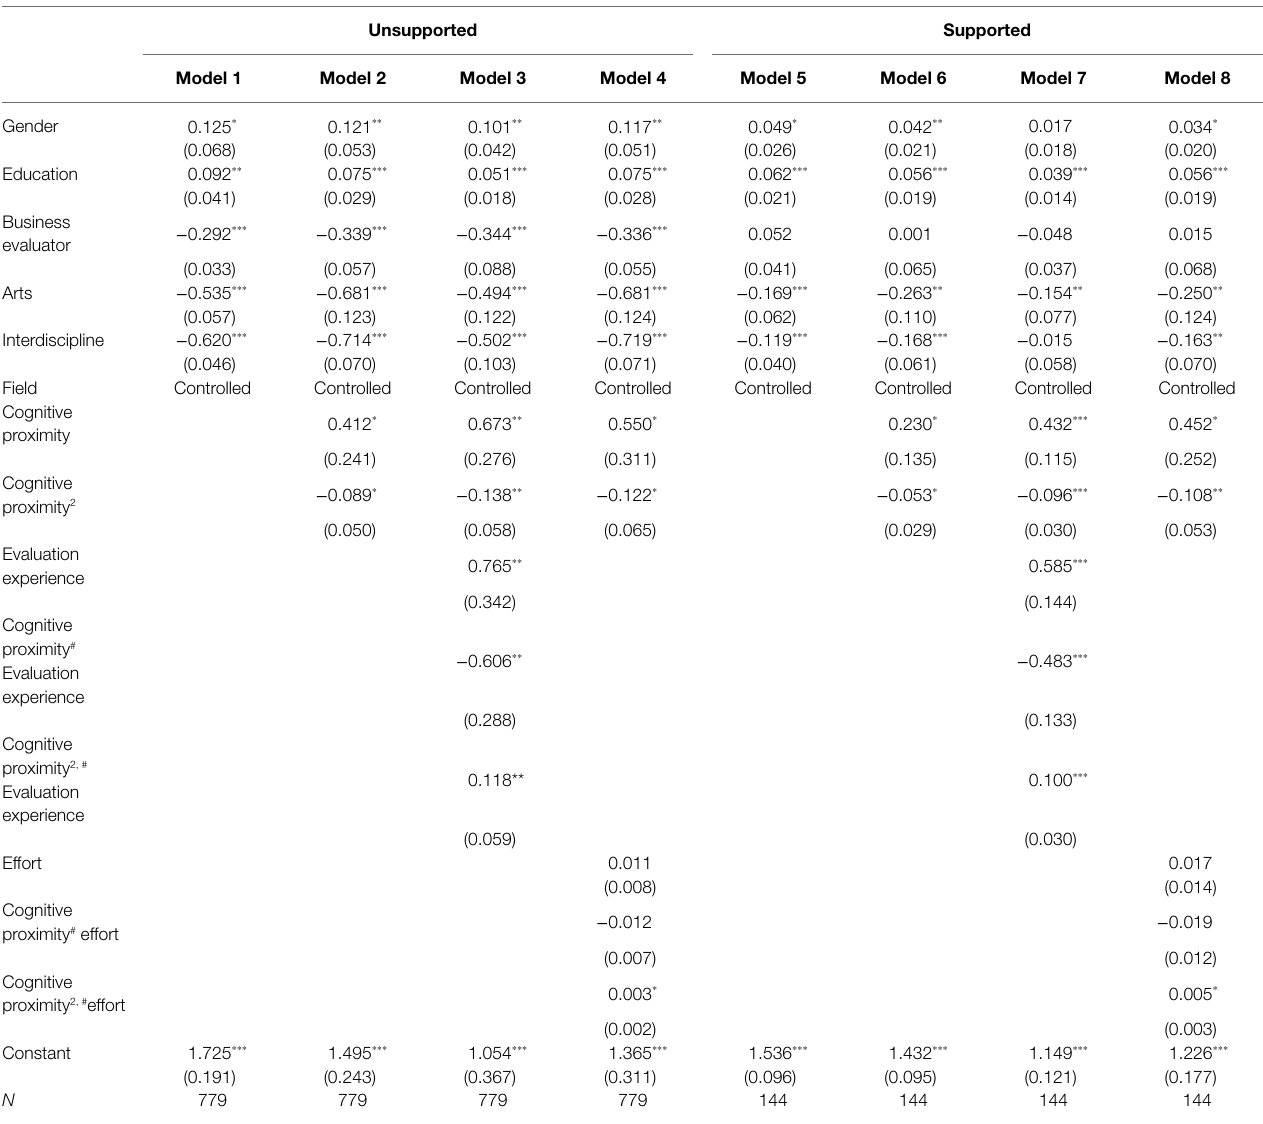
TABLE 3 | Poisson regression